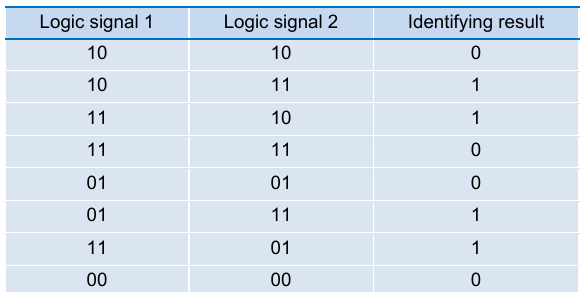
Table 2 | The two-digit state of logic signal 1 and logic signal 2 of the all-optical integrated photonic circuit and the identifying